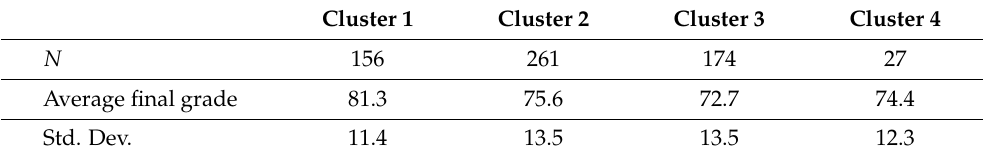
Table 5. Size, Average Final Grade, and Standard Deviation of clusters formed with SRLAS dimensions.